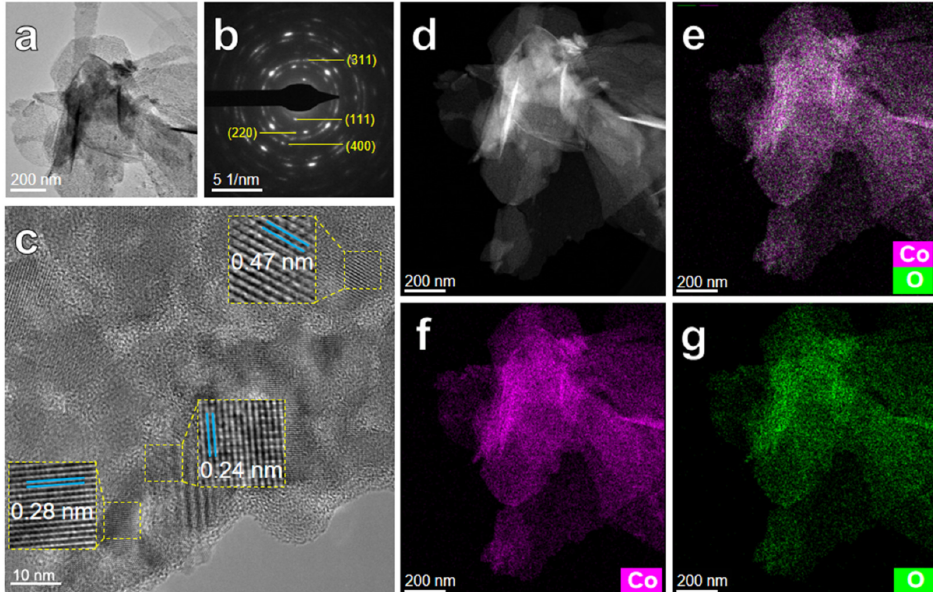
Figure 4. TEM images of nanopetals layer of the Co 3 O 4 @NP-CuO composite: ( a ) high magnification image; ( b ) SAED pattern; ( c ) HRTEM image; EDS mapping images of nanopetals of ( d ) dark field image; ( e ) Co and O mixed; ( f ) Co; ( g ) O.